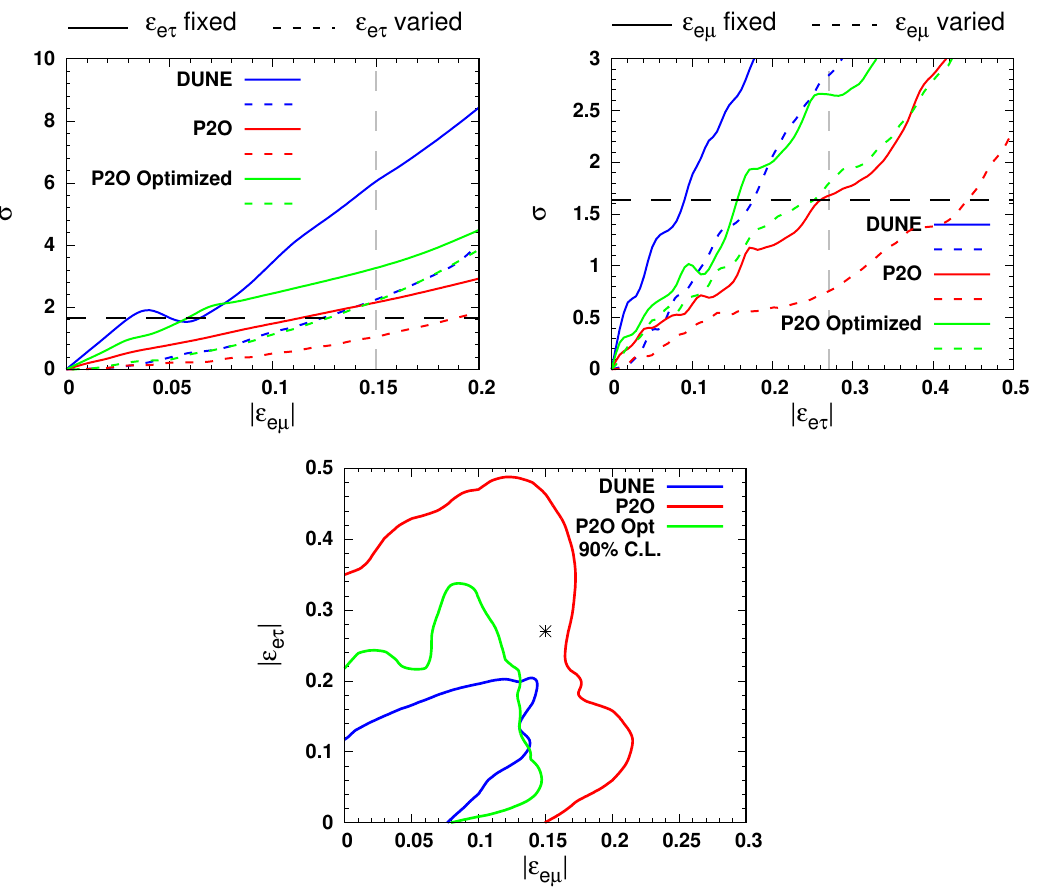
Figure 3 . Capability of P2O and DUNE to constrain the NSI parameters. In the top left (top right) panel we present the one-dimensional sensitivity curves for | (cid:15) eµ | ( | (cid:15) eτ | ). In the bottom panel we present 90% contours in the | (cid:15) eµ | - | (cid:15) eτ | plane. These panels are generated for true normal hierarchy.